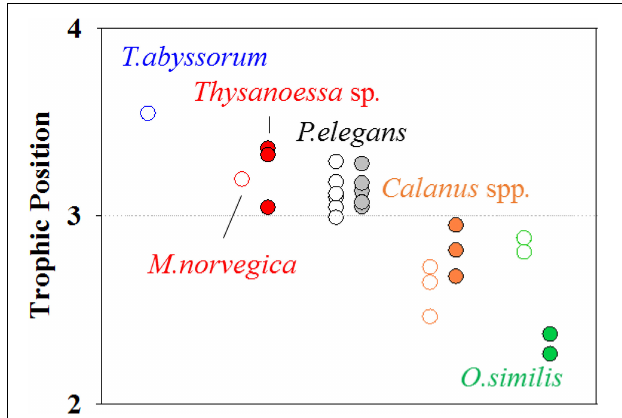
FIGURE 4 | The difference of the TP values of zooplankton species before (open circle) and after polar night (closed circle).